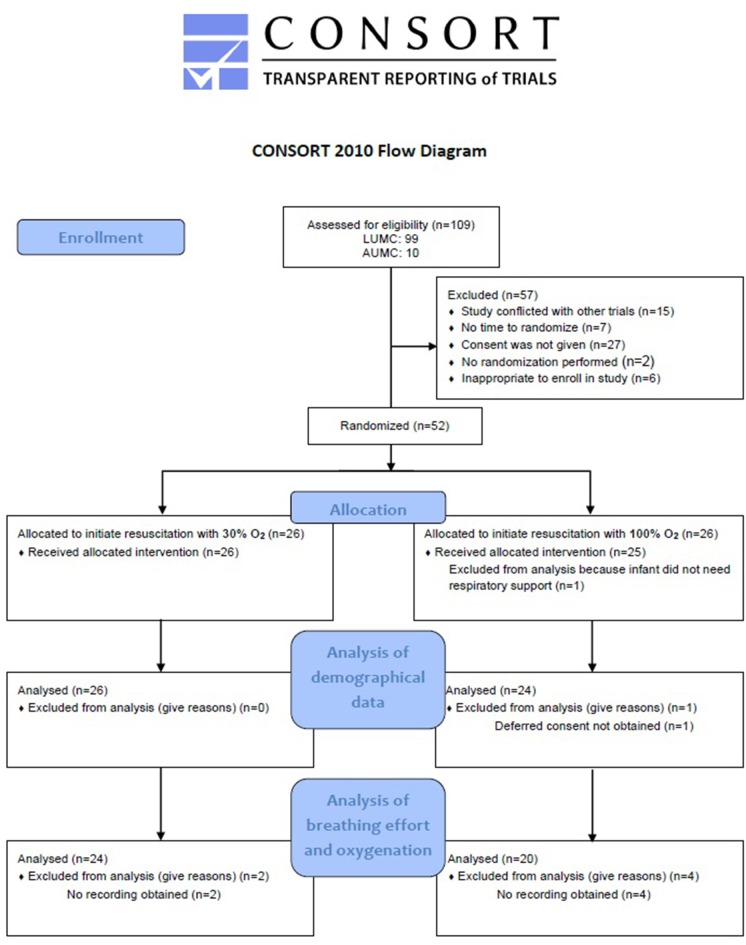
Flow diagram of allocation and analysis. LUMC, Leiden University Medical Centre; AUMC, Amsterdam University Medical Centre.